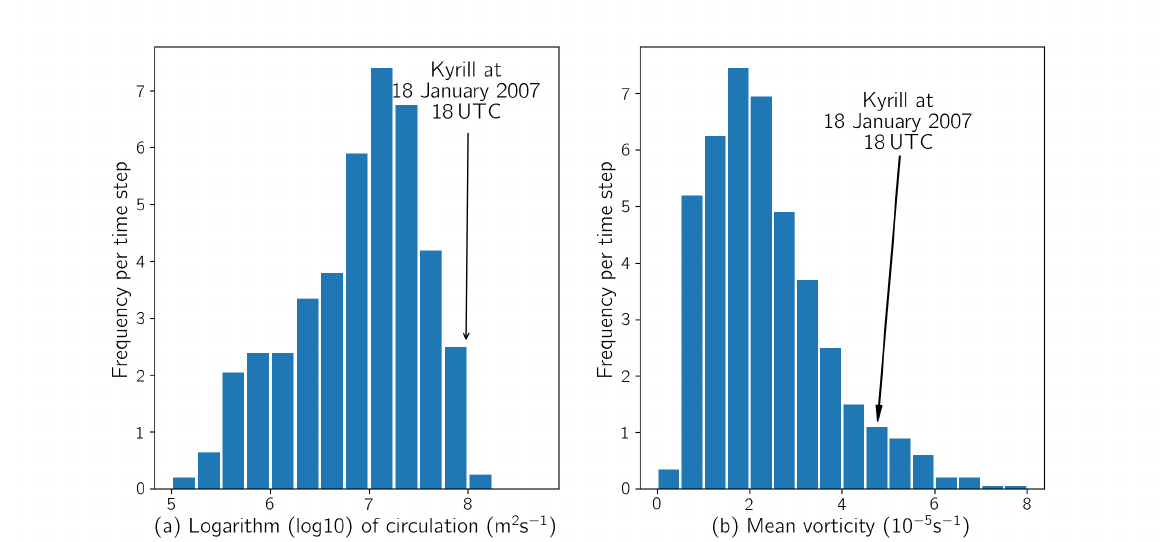
Figure 5. Frequency distributions of vortex properties of cyclonically-rotating vortices identified in the Northern Hemisphere ( ≥ 25 ◦ N) during the period 15 January 2007 00UTC–19 January 2007 18UTC at 850hPa in NCEP data. ( a ) Circulation Γ (m 2 s − 1 ) and ( b ) mean vorticity ζ (10 − 5 s − 1 ) averaged over the identified vortex area (estimated by